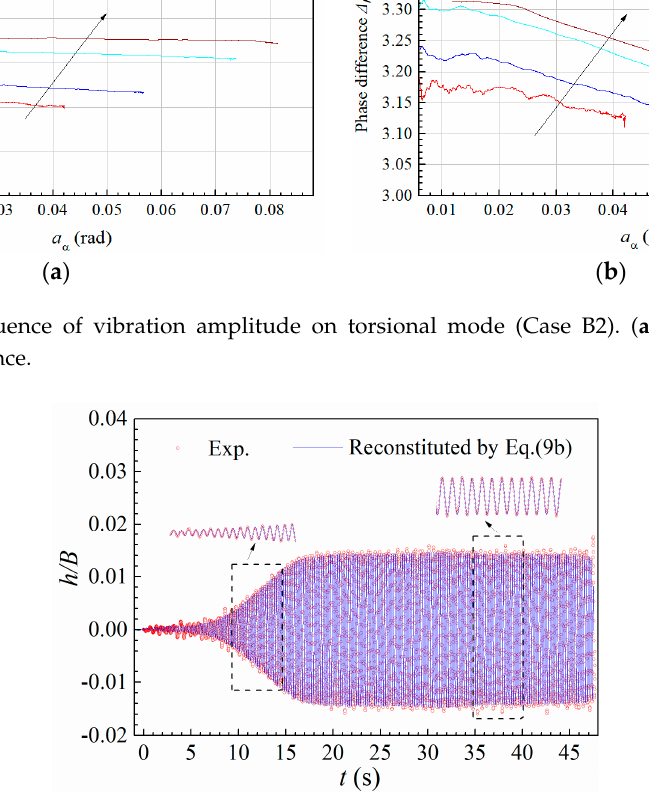
Figure 11. Comparison of a heaving LCO reconstituted from amplitude-dependent mode and experimental result (Case B2, U * = 7.575).